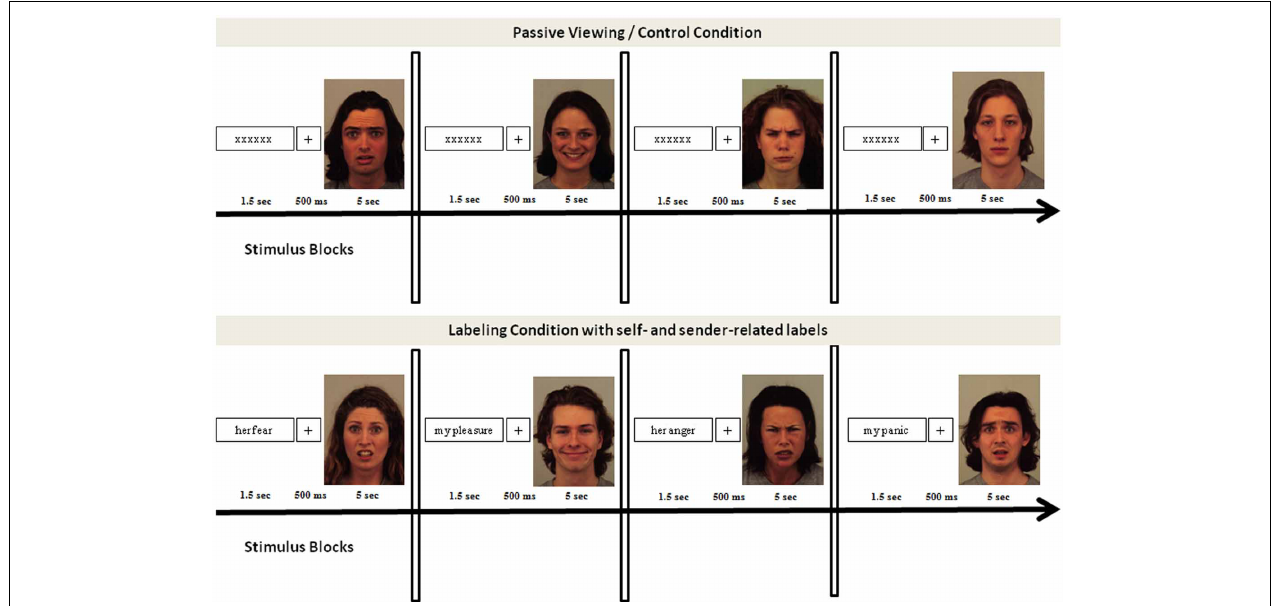
FIGURE 1 | Experimental set-up of experiment 1 and experiment 2. Both experiments used the same design, consisting of a control condition and an affective label condition. The control condition was always presented first and consisted of blocks of fearful, happy,